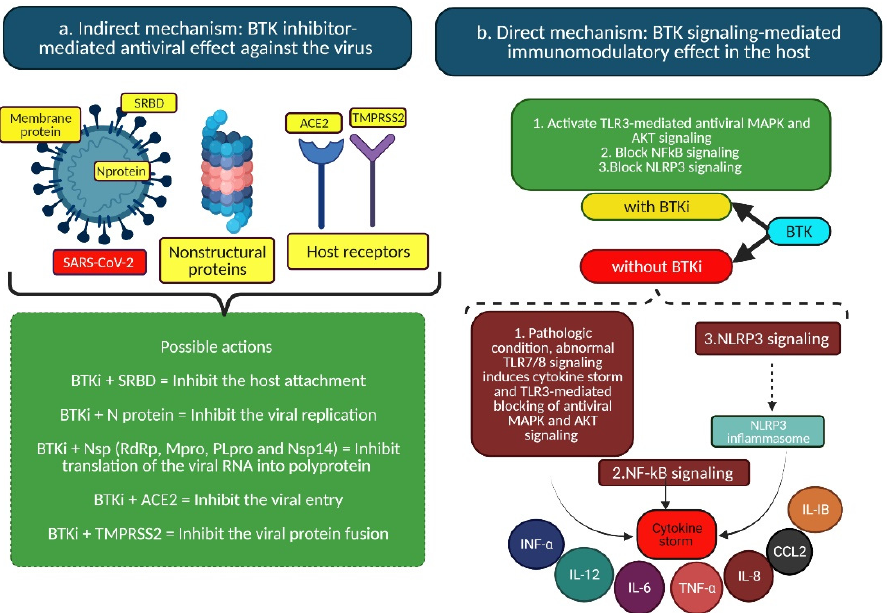
Figure 7. Schematic illustration of the possible mechanism of action of BTK inhibitors: a) direct mechanism of BTKi with BTK signaling-mediated immunomodulatory effect in the host; b) indirect mechanism with BTKi-mediated antiviral effect against SARS-CoV-2. ACE2—angiotensin converting enzyme 2; Akt—protein kinase B; BTKi—Bruton’s tyrosine kinase inhibitor; CCL2—chemokine ligand 2; IL—interleukin; IFN—interferon; MAPK—mitogen-activated protein kinase; NSP—nonstructural protein; NF- κ B—nuclear factor- κ B; NLRP3—NLR family pyrin domain-containing 3; SRBD—spike protein receptor-binding domain; TLR—toll-like receptors; TMPRSS2—transmembrane serine protease 2; TNF—tumor necrosis factor.